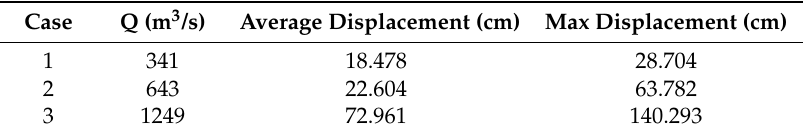
Table 1. Statistics of UAV offset displacements.